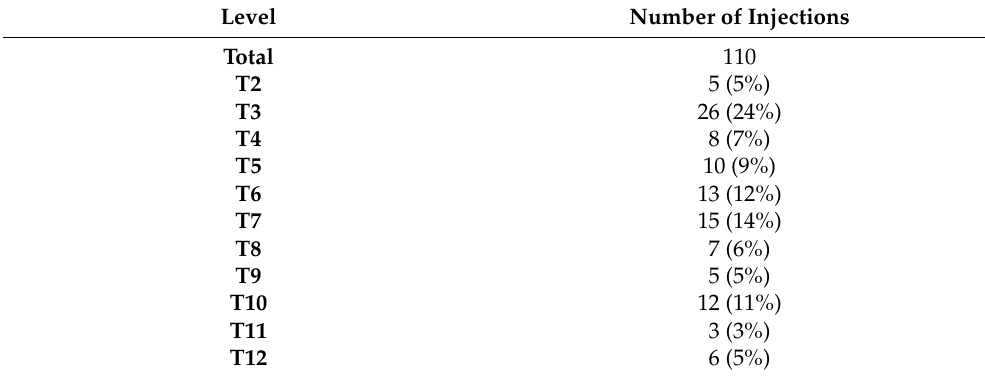
Table 2. Level of